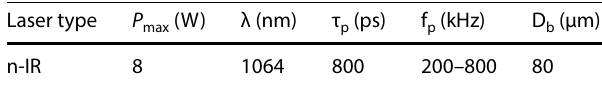
drawings represent the laser intensity output in a given position Fig. 2 Illustration of the laser cleaning apparatus used for the pre- as a function of time for the burst pulse mode employed to control sent study (left), where the laser x–y scanner head is shown above thermal damage [42, 43]. The lower inset graphically illustrates the the archaeological artifact sample and a fume extraction device. pulse width (τ The upper centre inset illustrates the ideal sample behaviour under = 800 ps) and pulse-to-pulse (interpulse) separation p laser irradiation, where the contaminant layer is removed, while (ca. 2 µs) on the left side. On the right side it provides an illustra- the protective patina (green) is preserved. The upper right inset tion of how thermal incubation takes place along the consecutive represents the relationship between laser intensity and different pulse irradiation process. Between bursts, a much larger time inter- definitions of beam waist related to a Gaussian beam profile, high- val that depends on the particular geometry selected to make the lighting the 1/e 2 criterion used in this study [41]. The lower inset laser treatment (ca. 0.4 s) is indicated Table 1 Characteristic emission of the sub-ns laser employed for the present study. Values are given for the nominal (maximum) out- put power ( P ), emission wavelength (λ), pulse width (τ ), pulse max p repetition rate (f ), and beam waist applying the 1/e 2 criterion (D ) p b for a Gaussian beam distribution (Fig.